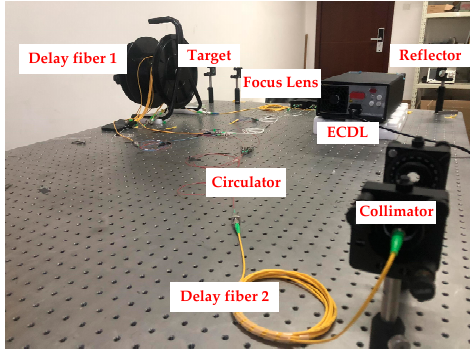
Figure 5. Frequency modulation continuous wave (FMCW) laser ranging system diagram.